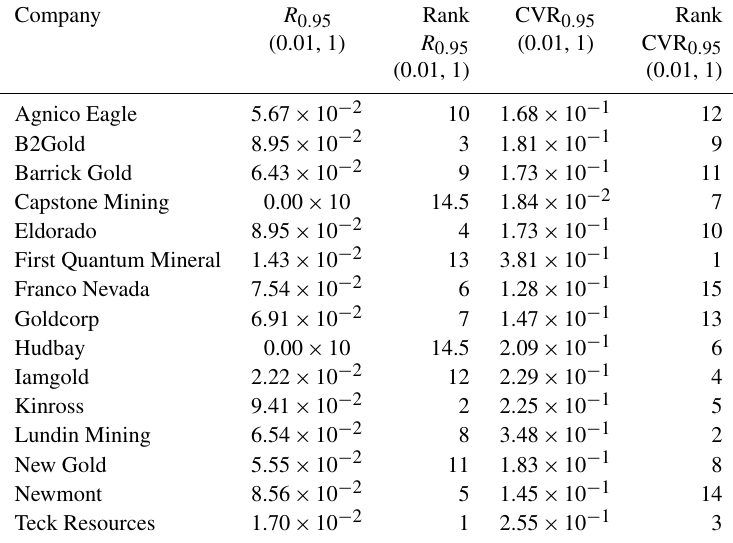
Table 2. Ranking of 15 companies based on R 0 . 95 (0.01, 1) and CVR 0 . 95 (0.01, 1) measures for a 1-day rainfall event, obtained using the 20CR dataset and mine valuation obtained from broker reports from TD